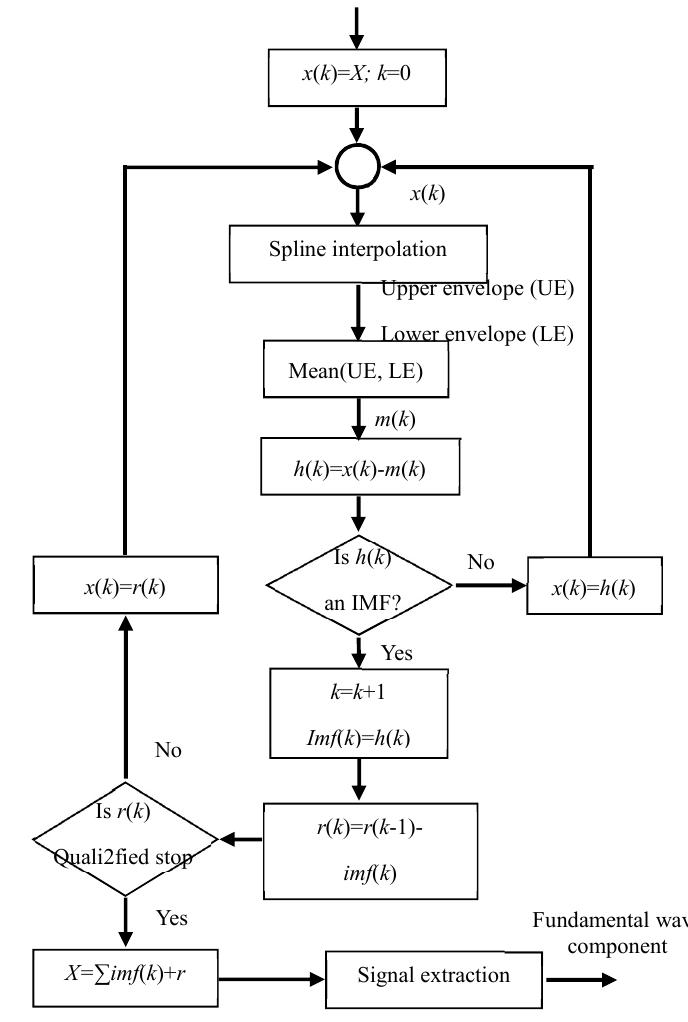
Figure 3. Block diagram of EMD-based extraction approach.